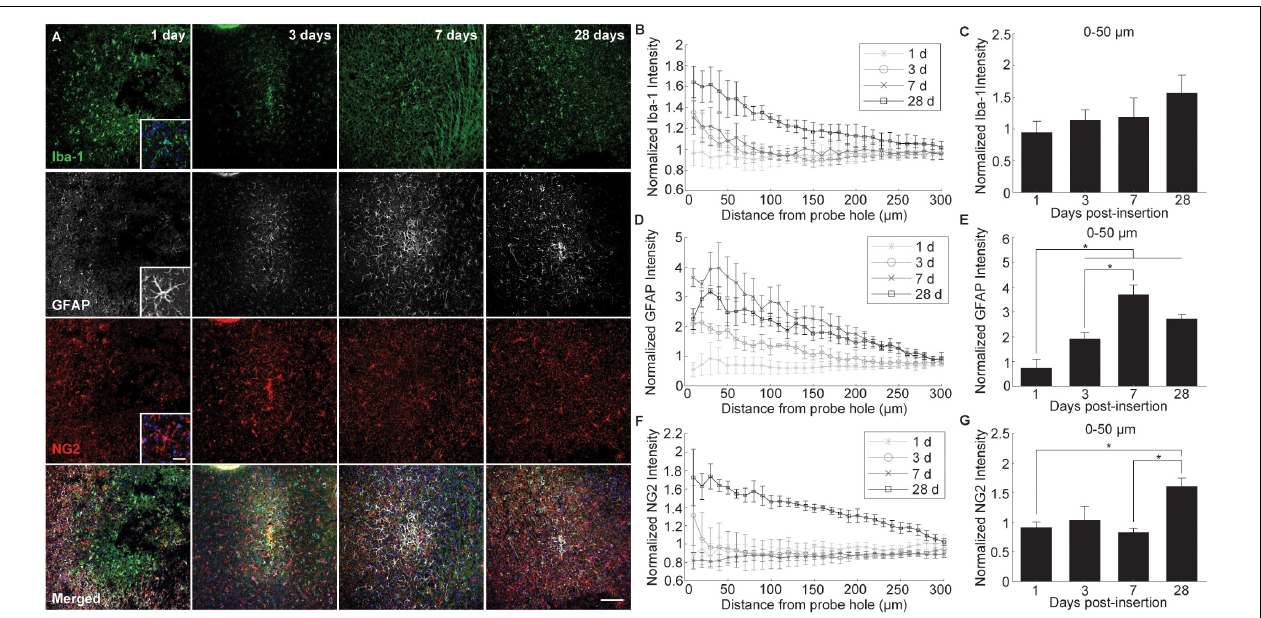
FIGURE 3 | Evaluation of glial cell activation around an implanted microelectrode array. Microelectrode implantation induces distinct spatial and temporal patterns of microglia, astrocyte, and NG2 glia reactivity. (A) Representative immunohistochemical stain for microglia (Iba-1), NG2 glia (NG2), and astrocytes (GFAP) at 1, 3, 7, and 28 days post-insertion. Scale bar = 100 µ m. Inserts show magnified view of Iba-1+, GFAP+, and NG2+ cells with nuclei stain. Scale bar = 20 µ m. (B) Normalized Iba-1 intensity within 10 µ m bins up to 300 µ m away from the probe hole. (C) Linear increases in microglia reactivity around the implanted device is depicted as normalized Iba-1 intensity averaged over the first 50 µ m from the probe hole. (D) Normalized GFAP intensity within 10 µ m bins up to 300 µ m away from the probe hole. (E) Normalized GFAP intensity averaged over the first 50 µ m from the probe hole demonstrates temporal patterns in astrocyte scar formation around the implanted device. (F) Normalized NG2 intensity within 10 µ m bins up to 300 µ m away from the probe hole. (G) Normalized NG2 intensity averaged over the first 50 µ m from the probe hole demonstrates a significant increase in NG2 expression at chronic timepoints. NG2 intensity decreases at 7 days when GFAP intensity peaks. Additionally, NG2 intensity peaks at 28 days as oligodendrocyte degeneration decreases and myelination increases. ∗ indicates p < 0.05.